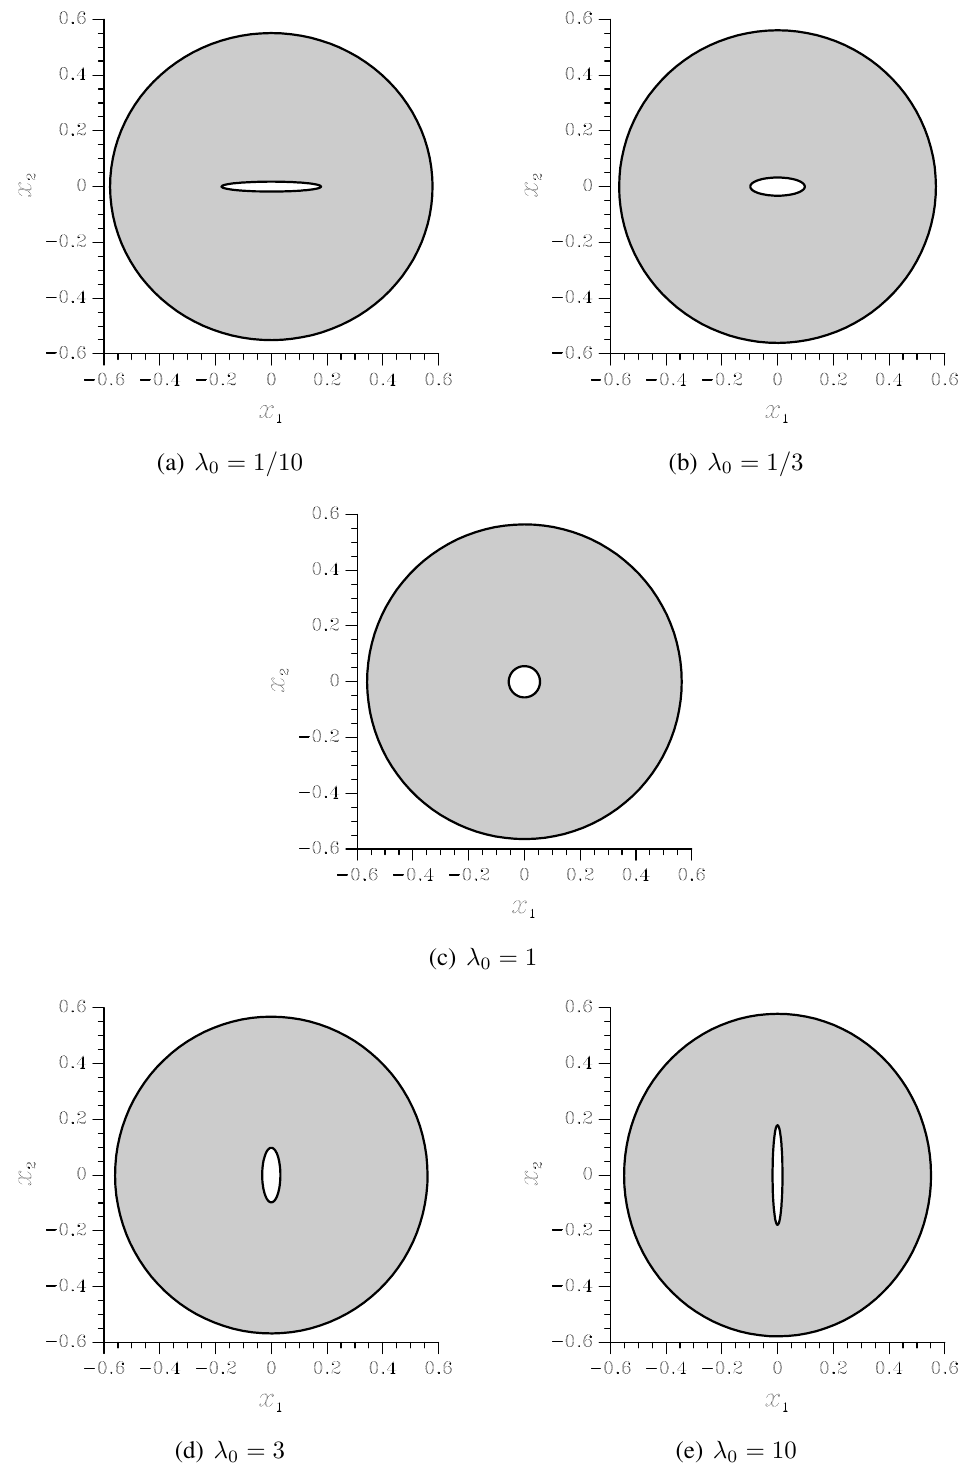
Figure 3 . Undeformed RVE cross-sections at f λ (measures in mm). As a reference, in this figure the volume V (see Equations 1) and 0 the out-of-plane thickness L of the RVE has been respectively assumed V = 1 mm 3 and L = 1